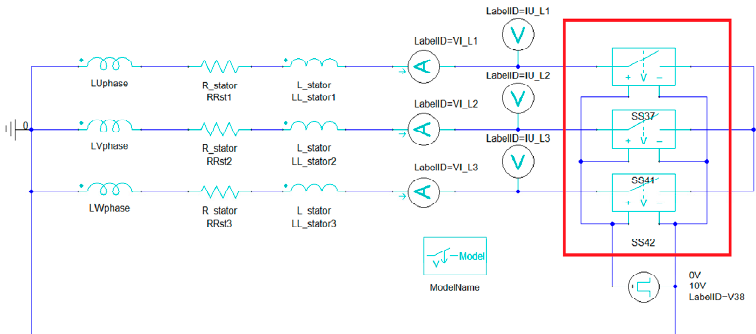
Figure 14. Maxwell’s Circuit Editor schematic; red rectangle shows the short circuit position.